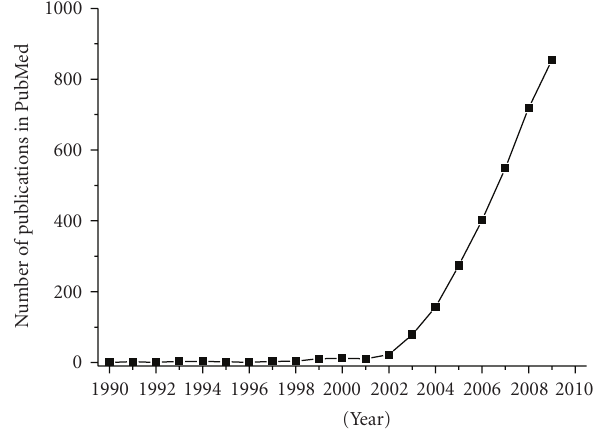
Figure 1: Scientific publications in PubMed about MSCs. The PubMed database was searched for the terms “mesenchymal stem cell,” “mesenchymal stromal cell,” and “MSC” for the years 1990– 2009. The emerging interest in MSCs is seen by the increasing number of publications.